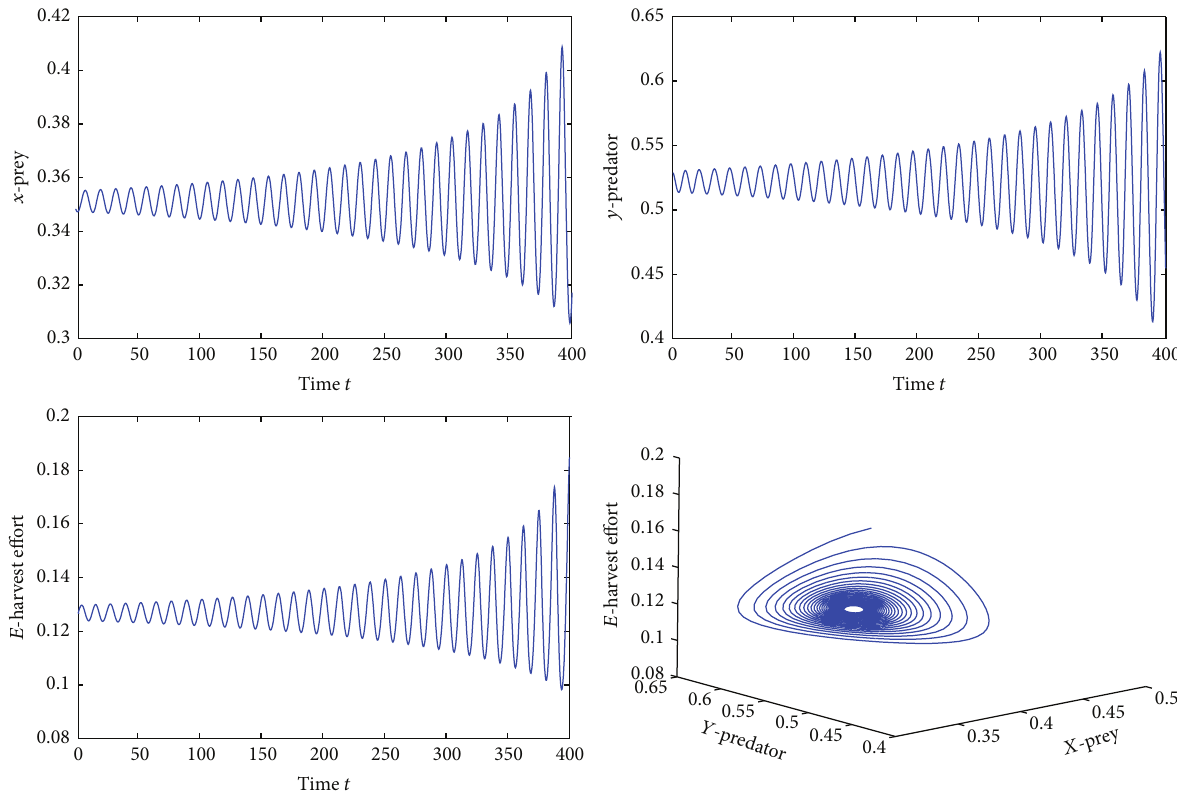
Figure 3: When 𝜇 = 0.171 > 𝜇 0 , the positive equilibrium point 𝑋 0 (𝜇) is